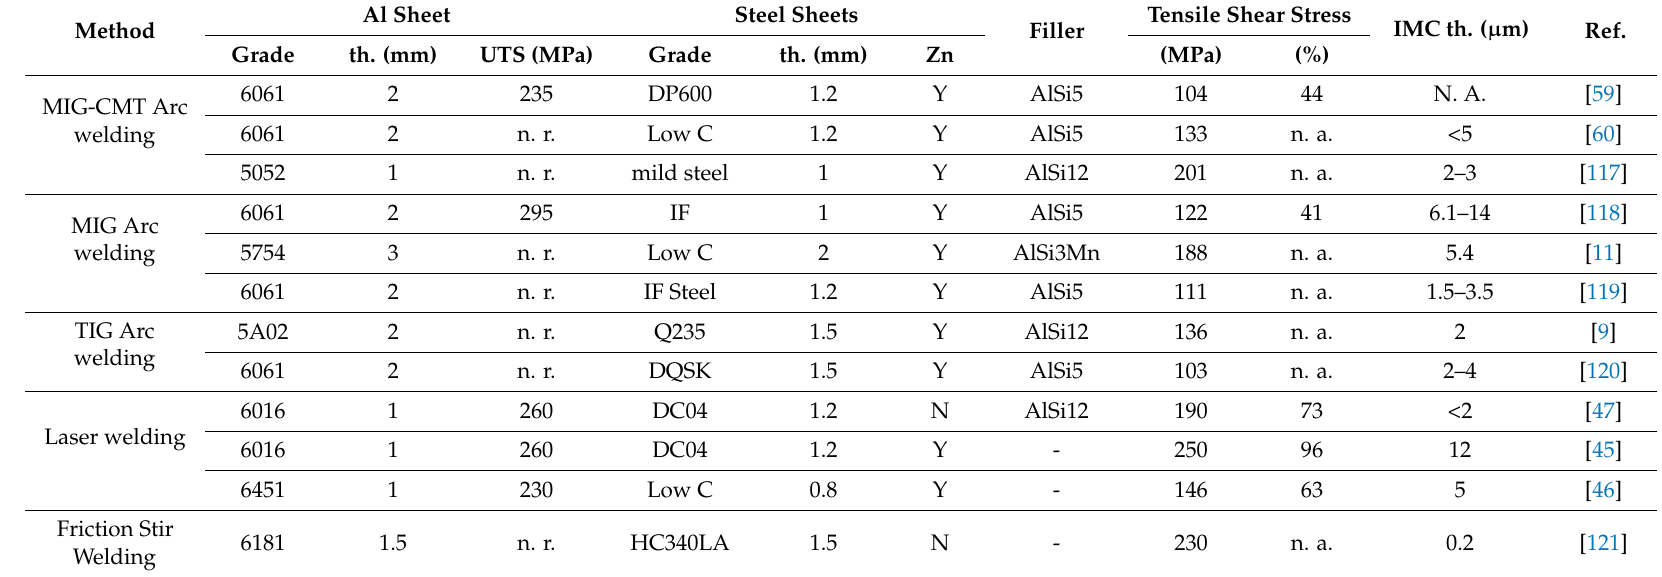
Table 2. Main results of hybrid continuous (linear) lap welding